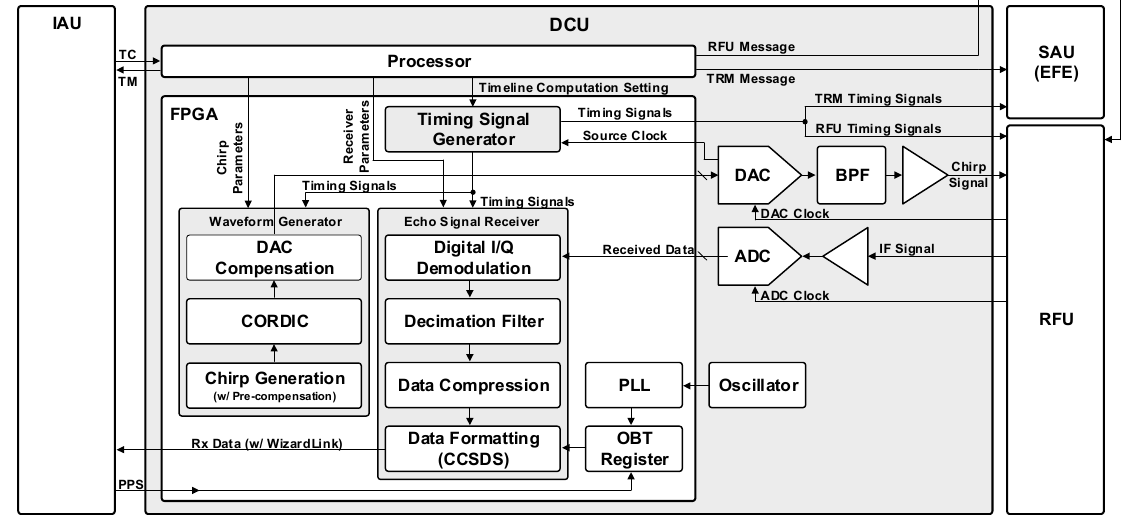
Figure 15. Functional block diagram of the S-STEP DCU.